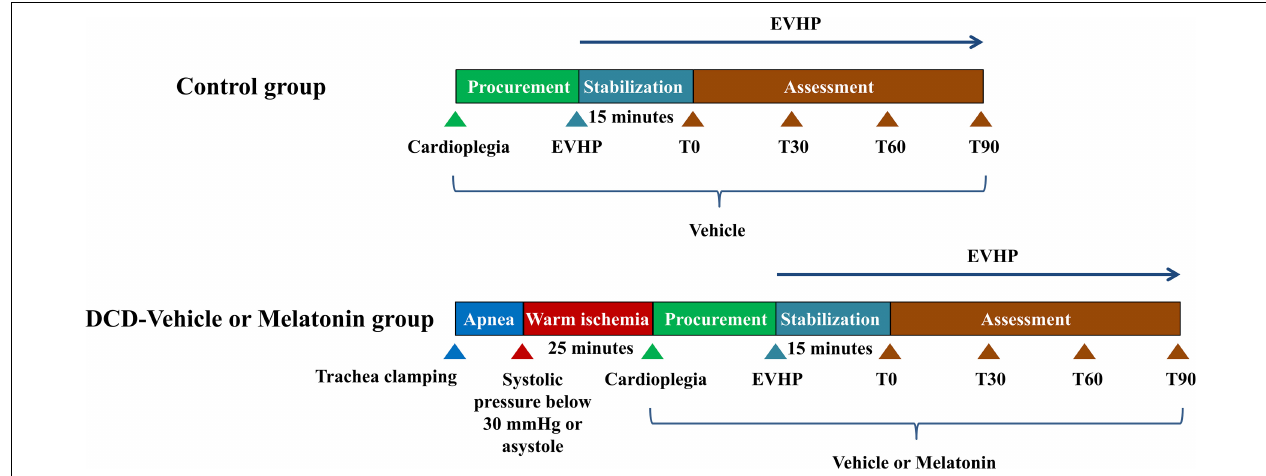
FIGURE 1 | Study protocol of ex vivo heart perfusion combined with melatonin in the DCD heart preservation. DCD, donation after circulatory death; EVHP, ex vivo heart